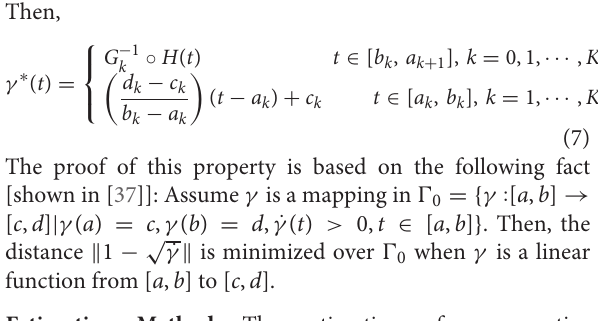
Figure 5B . The warped intensity functions, λ i ( t )